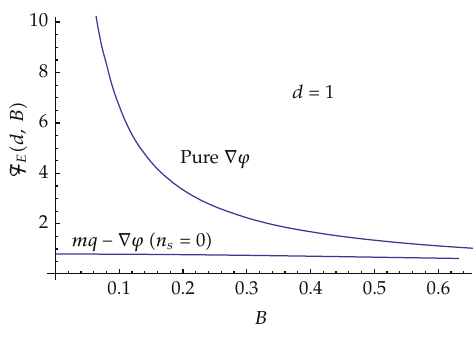
Figure 16: The free energy as a function of the density of the pure pion gradient phase compared to the multiquark- ∇ ϕ phase at fixed d (cid:8) 1 . 0 , T (cid:8) 0.